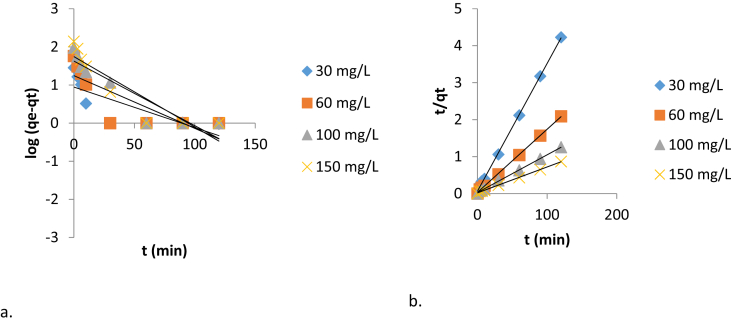
Plots of (a) pseudo-first-order, (b) pseudo-second-order kinetics for Pb2+ on HCl activated Aloji clay at 30 °C.